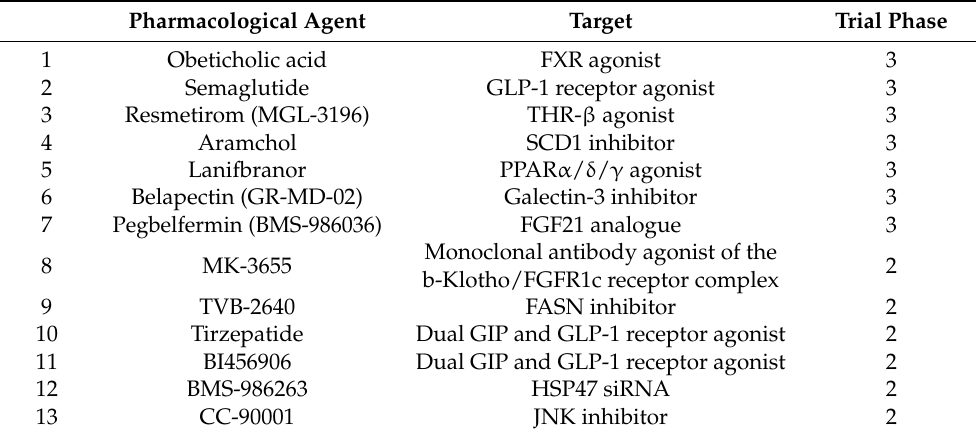
Table 1. Potential agents for the treatment of